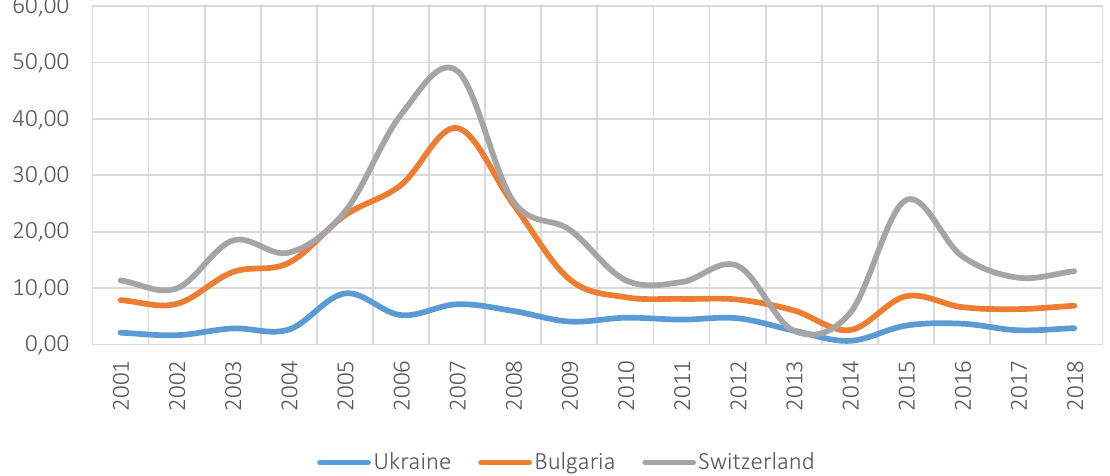
Figure 4. Foreign direct investment, net inflows, % of GDP